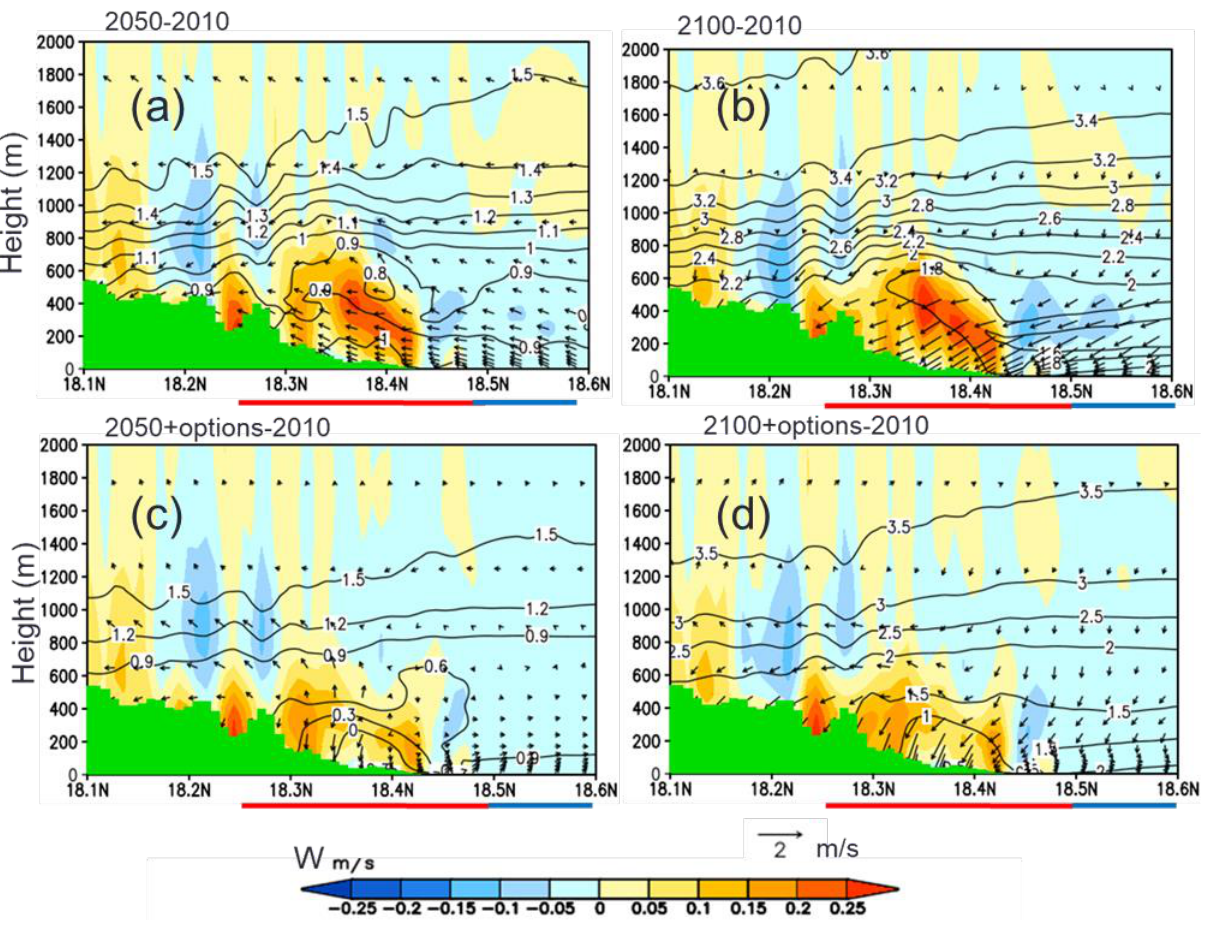
Figure 10. Air temperature difference (contour lines), horizontal wind vector difference, and shaded contour of vertical wind for mean of 18 UTC (2 PM LST). The red line represents urban locations and blue line delineates ocean. The blue shaded colors represent downward vertical motion, whereas the yellow–red shows upward vertical motion. The green filled solid line represents topography. ( a ) contour lines temperature difference (2050–2010) vertical wind difference shaded contours ( b ) temperature difference, wind difference (2100–2010) ( c ) temperature difference, wind difference 2050 with mitigation options — 2010 ( d ) temperature difference, wind difference 2100 with mitigation options—2010.